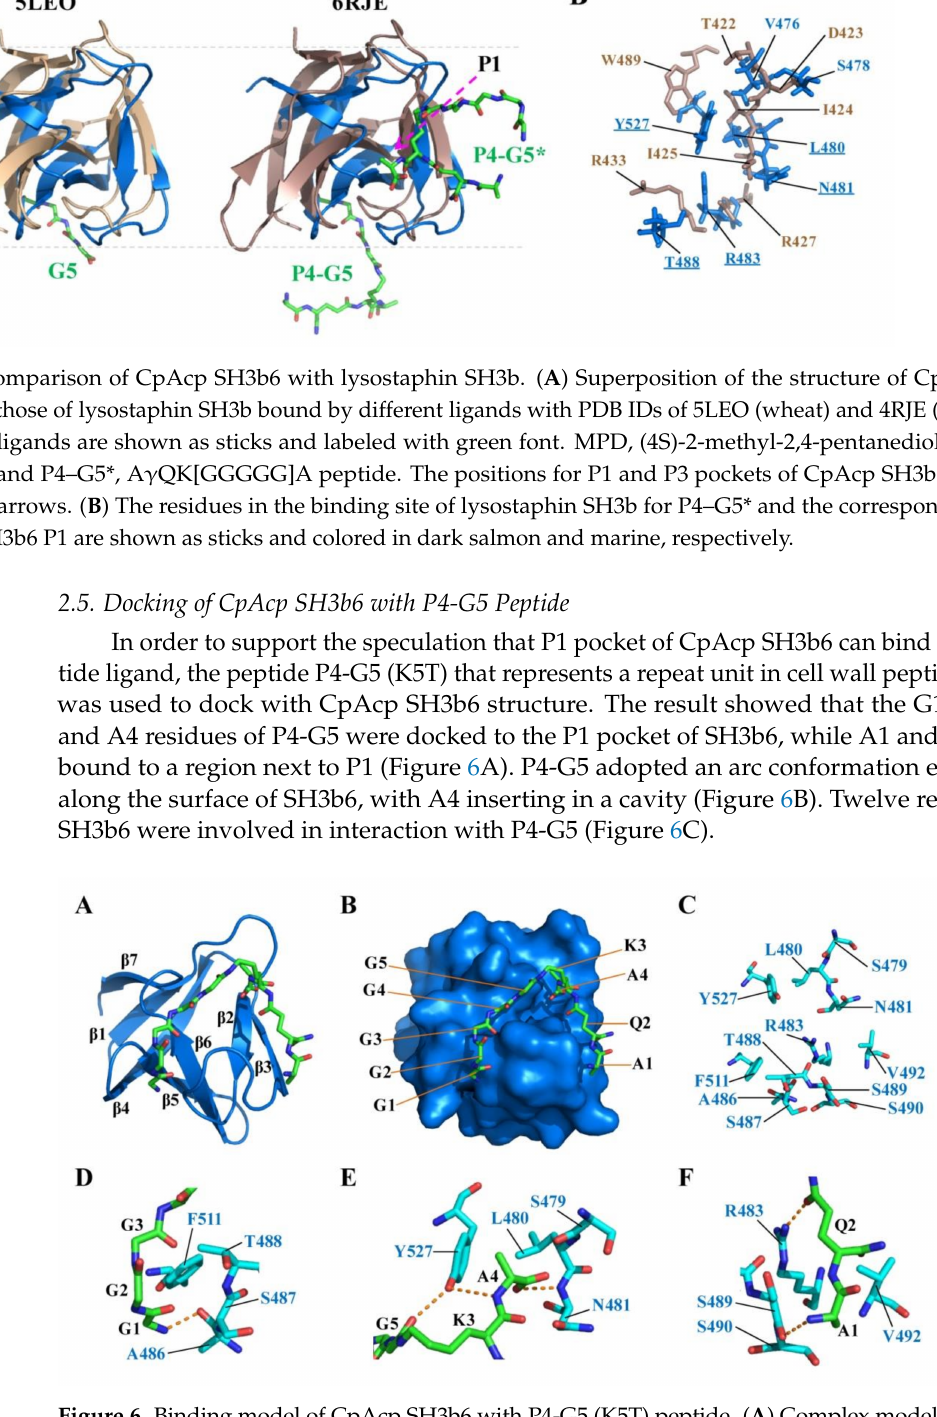
Figure 6. Binding model of CpAcp SH3b6 with P4-G5 (K5T) peptide. ( A ) Complex model of CpAcp SH3b6 bound by P4-G5 with SH3b6 shown in cartoon (marine) and P4-G5 peptide in stick representation. Secondary elements of SH3b6 are marked. ( B ) Complex model of CpAcp SH3b6 bound by P4-G5 with SH3b6 in surface (marine) representation. Amino-acid units of P4-G5 are marked. ( C ) The residues of SH3b6 involved in interaction with P4-G5 are shown as sticks. ( D – F ) Three interacting sites between SH3b6 and P4-G5 are shown with carbon colored in cyan and green, respectively. The interacting residues are indicated. Hydrogen bonds are shown as orange dashed